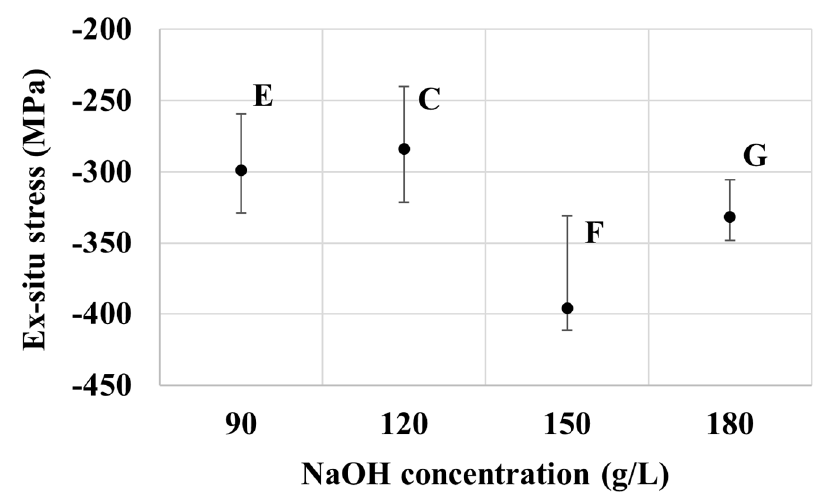
Figure 9. E ff ect of NaOH concentration on the ex-situ stress of the samples from baths E, C, F, and G.